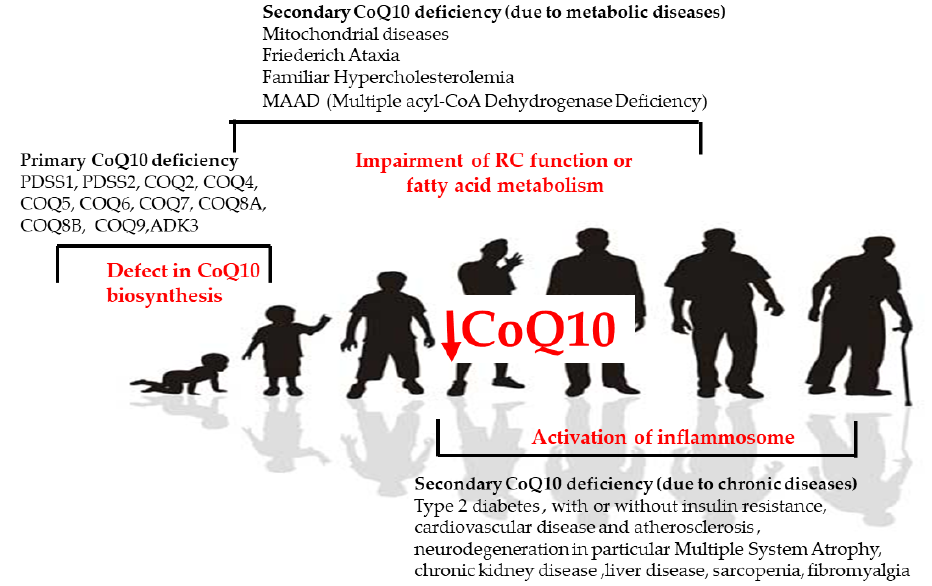
Figure 4. CoQ in human diseases. Causes of primary and secondary deficiency of CoQ10 in human